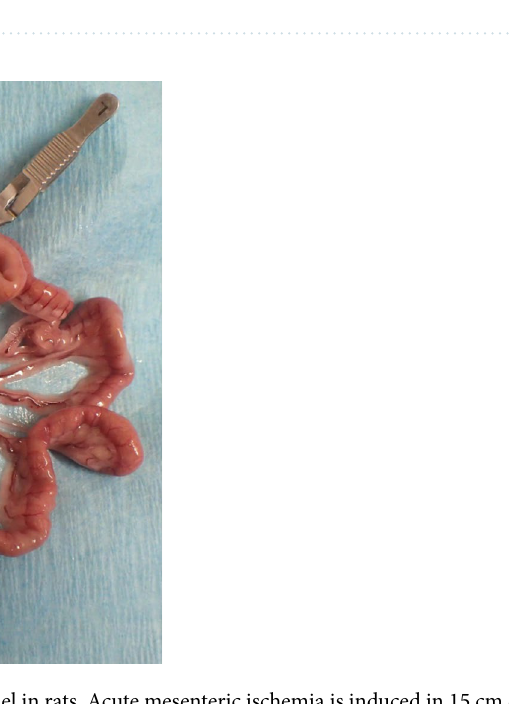
Figure 4. Strangulated bowel obstruction model in rats. Acute mesenteric ischemia is induced in 15 cm of ileum from the ileocecal valve using vascular clamps. Mesenteric arteries and veins and marginal arteries and veins are